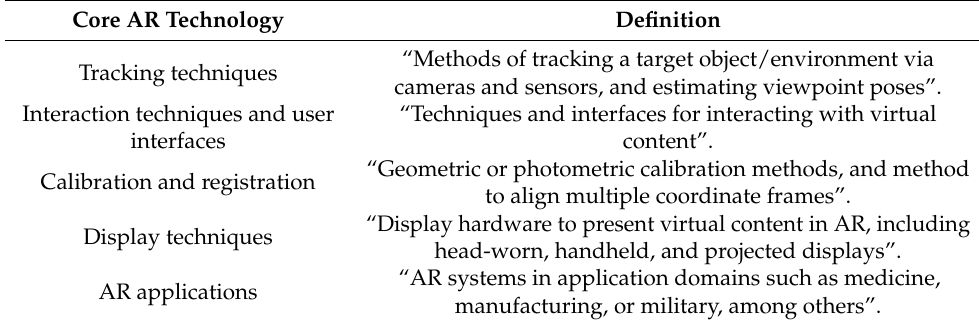
Table 1. Core augmented reality technologies and techniques [16].